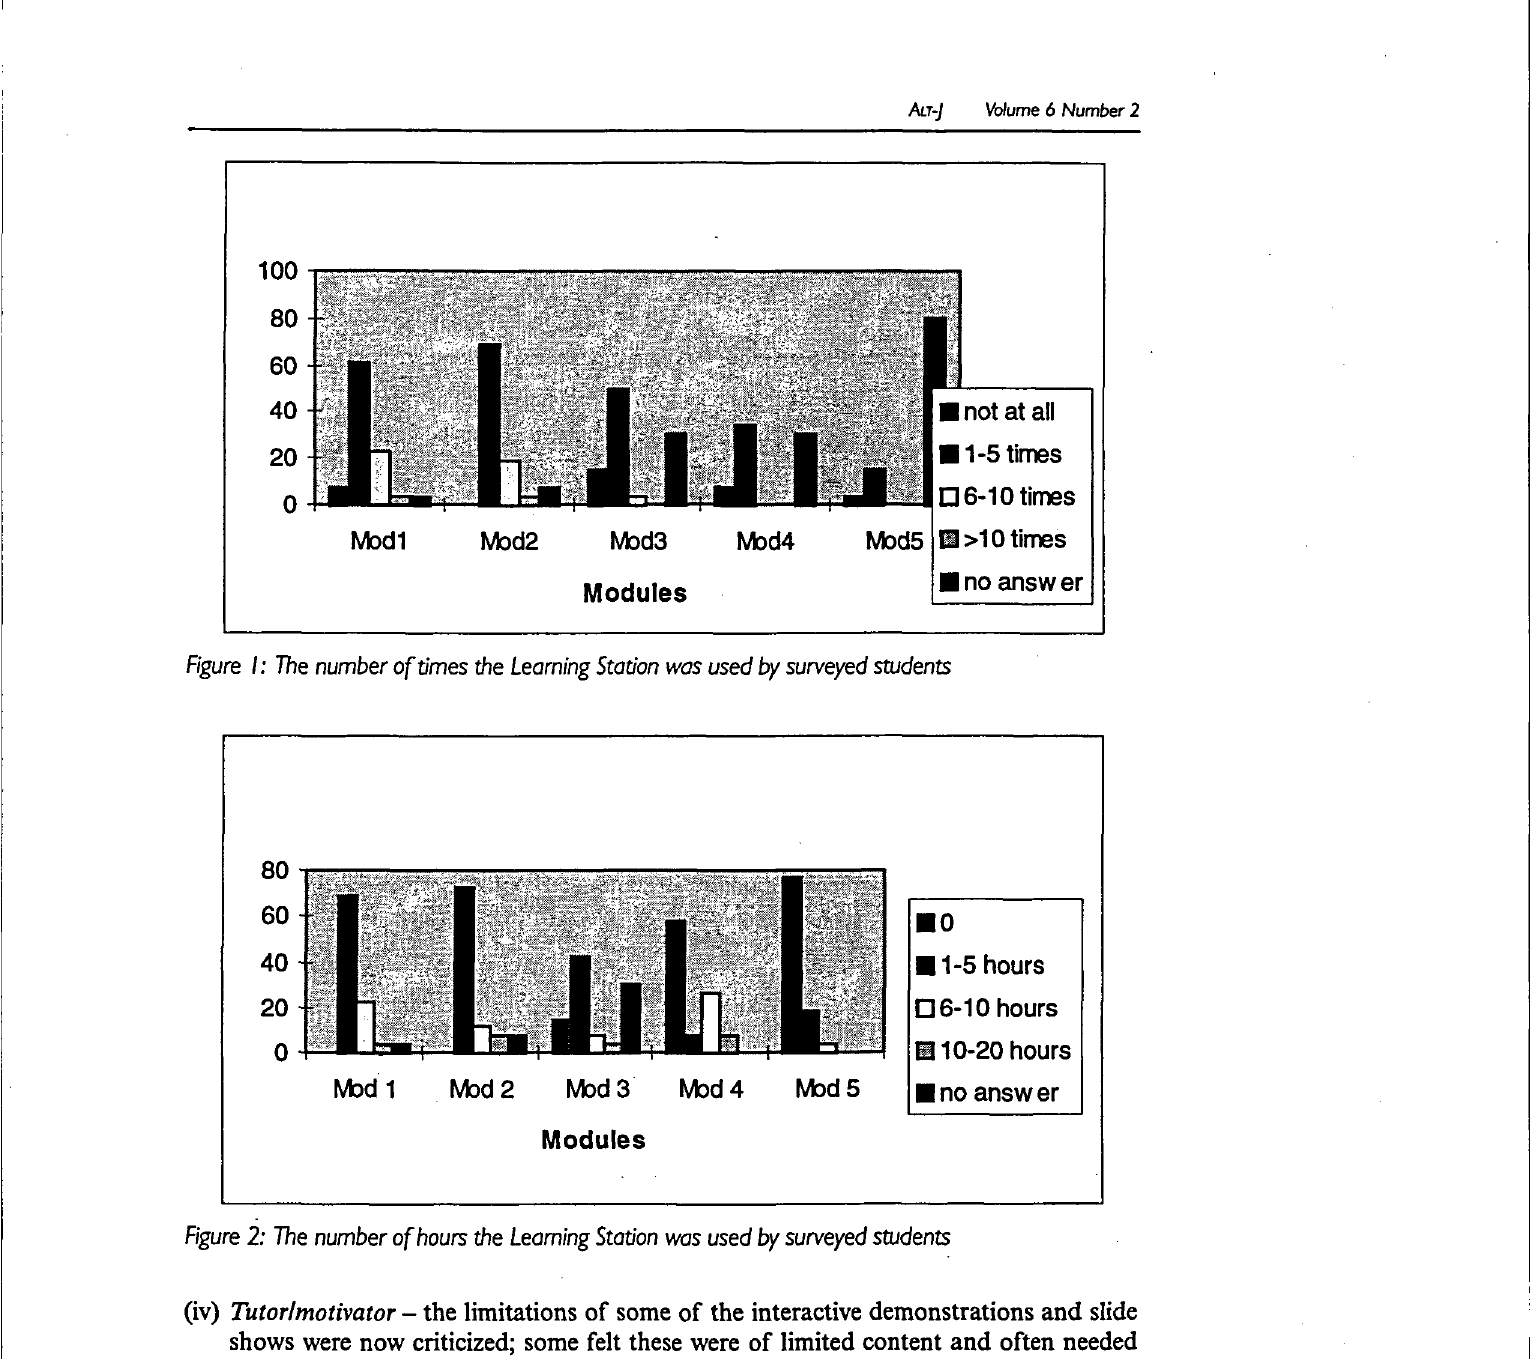
Figure 2: The number of hours the Learning Station was used by surveyed students (iv) Tutor/motivator - the limitations of some of the interactive demonstrations and